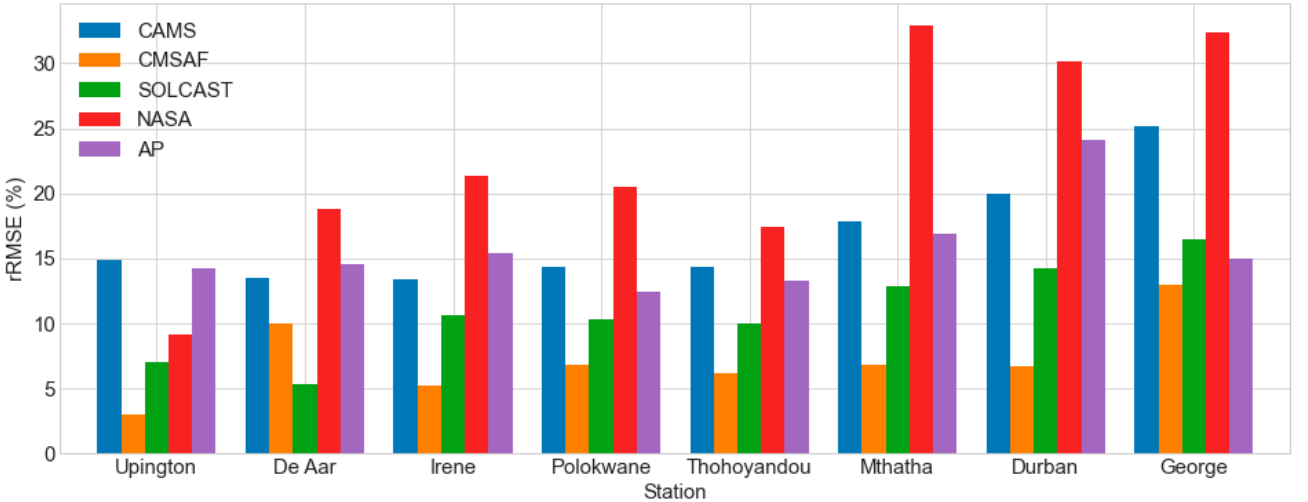
Figure 13. The daily rRMSE of the estimated GHI datasets for overcast-sky minus clear-sky condi- tions.